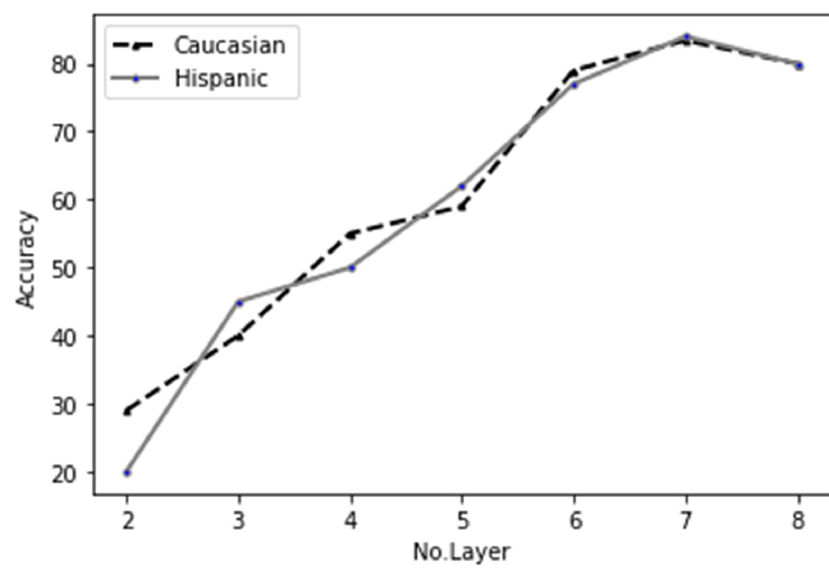
Figure 5. Evaluation of the number of layers of the proposed model.